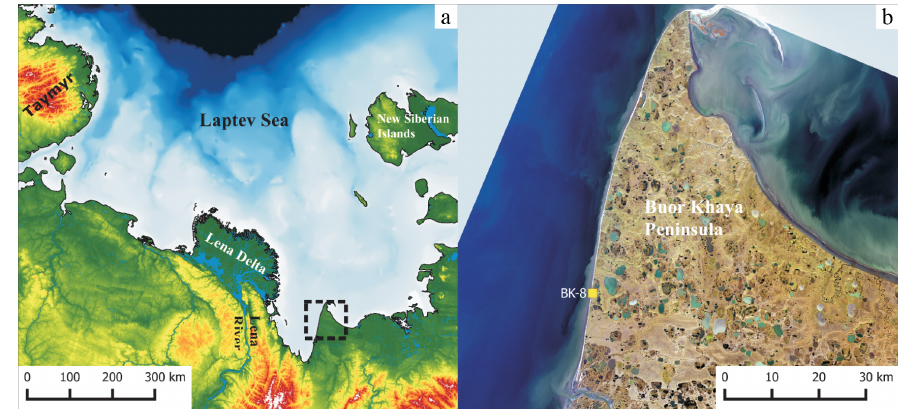
Figure 1. (a) Geographical setting of the study site in the southern Laptev Sea with the Buor Khaya Peninsula framed by dashed lines and (b) the position of the BK-8 drilling site on the western coast of the peninsula (compiled by Bennet Juhls).